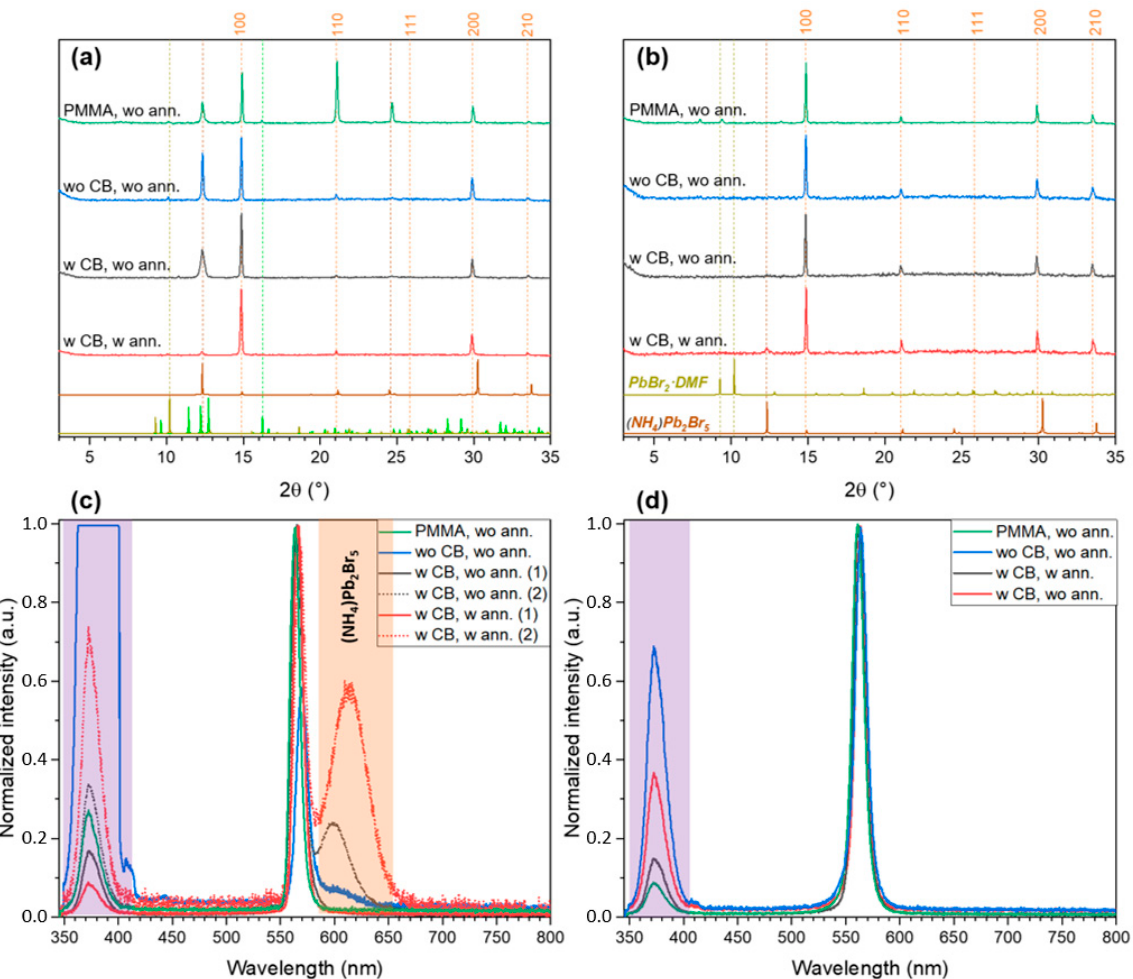
Figure 5. The XRD patterns ( a , b ) and PL spectra ( c , d ) of thin films with FABr:PbBr 2 = 1 spin-coated at different conditions from DMSO ( a , c ) and DMF ( b , d ) solutions. The dashed orange lines denote the reflections of FAPbBr 3 perovskite, other dashed lines indicate the positions of the most relevant reflections corresponding to reference XRD pattens plotted below ((NH 4 )Pb 2 Br 5 by brown, PbBr 2 ·DMF by olive, FAPbBr 3 ·DMSO by lime green). The light violet strip corresponds to the main band in the spectra of UV lamp (excitation source), the orange band corresponds to PL band of (NH 4 )Pb 2 Br 5 .